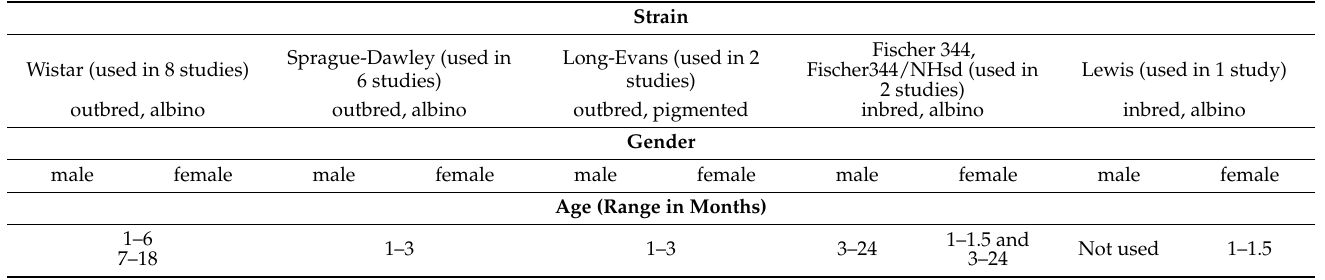
Table 1. Usage of animal strain; gender and age of animals, as reported by research groups. Strain Fischer 344, Sprague-Dawley (used in Long-Evans (used in 2 Lewis (used in 1 Wistar (used in 8 studies) Fischer344/NHsd (used in 6 studies) studies) 2 studies)